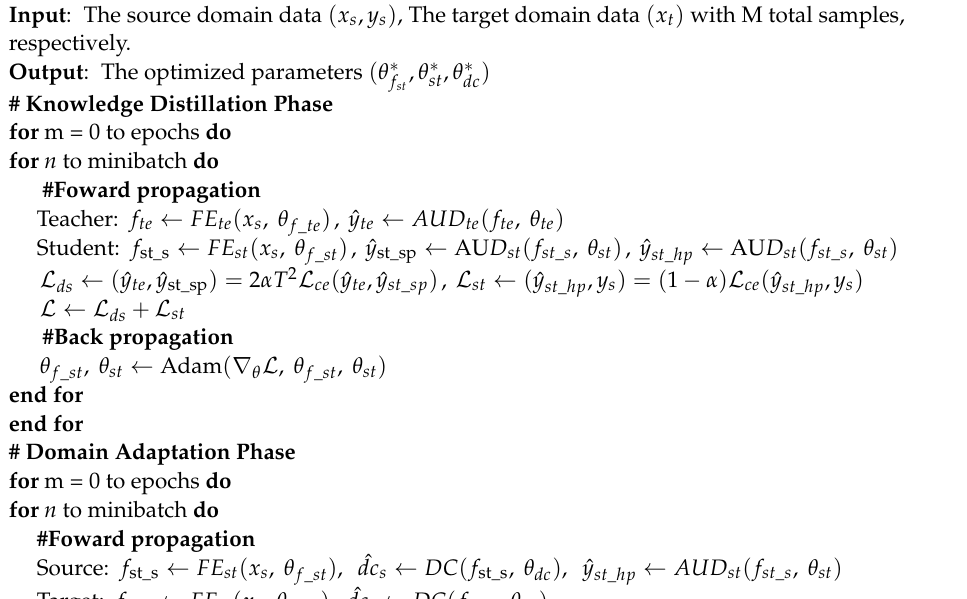
Algorithm 1: Parameter optimization procedure of the proposed